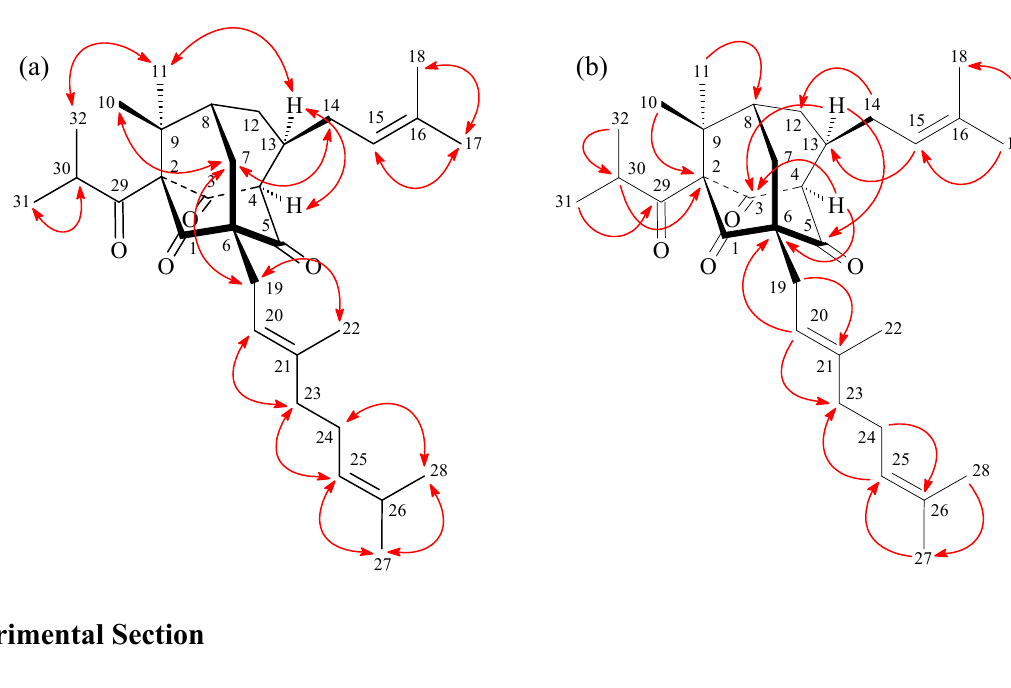
Figure 5. Key NOESY ( a ) and HMBC ( b ) correlations of 2